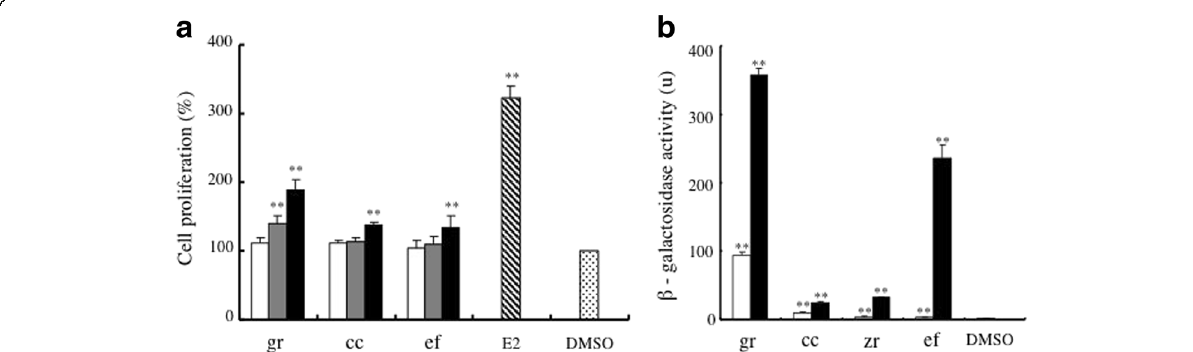
Fig. 3 The estrogenic activity of the crude drugs present in UKT. a MtT/Se cells were incubated with each of the crude drugs found in UKT at a concentration of 1 μ g/ml (white columns), 5 μ g/ml (gray columns), or 10 μ g/ml (black columns), and the cell proliferation induced by treatment with these crude drugs or 10 − 7 M of E2 for 6 days was evaluated. Cell proliferative activity is shown as a percentage compared with that induced by DMSO alone in the MTT assay. **significantly increased compared with the activity induced by DMSO, p < 0.01. b The β -galactosidase activity of all 12 of the crude drugs present in UKT was evaluated at concentrations of 0.1 mg/ml (white columns) and 0.5 mg/ml (black columns). The data for the crude drugs that did not display significant activity in the yeast two-hybrid assay are not shown. **significantly increased compared with the activity of DMSO, p < 0.01